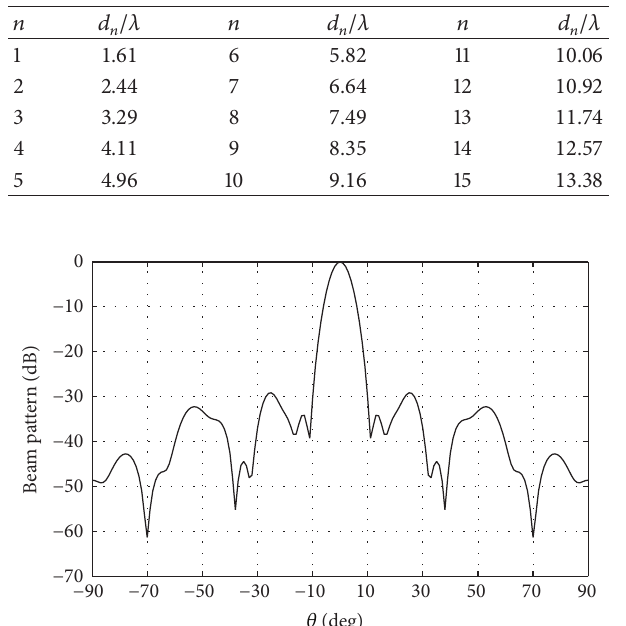
locations. In this instance the polarisation of the signal of interest is given by (𝛾, 𝜂) = (0 ∘ , 0 ∘ ) . The values of 𝛼 = 0.75 , 𝛽 = 0.1 , and 𝜀 = 1 were used in the constraints placed on the minimisation.